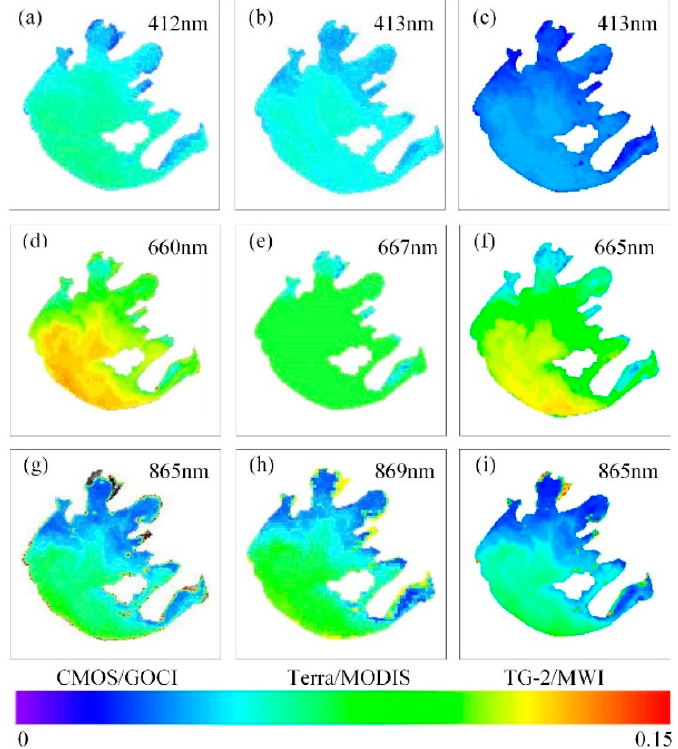
Figure 6. Comparison of the Rayleigh corrected reflectance of Communication, Ocean, and Meteorological Satellite (CMOS)/Geostationary Ocean Color Imager (GOCI) (( a ) 412 nm, ( d ) 660 nm, ( g ) 865 nm), Terra/MODIS (( b ) 413 nm, ( e ) 667nm, ( h ) 869 nm) and TG-2/MWI (( c ) 413 nm, ( f ) 665 nm, ( i ) 865 nm) of selected bands at 11:16 a.m., 11:00 a.m. and 11:03 a.m. on 14 March 2017, respectively.